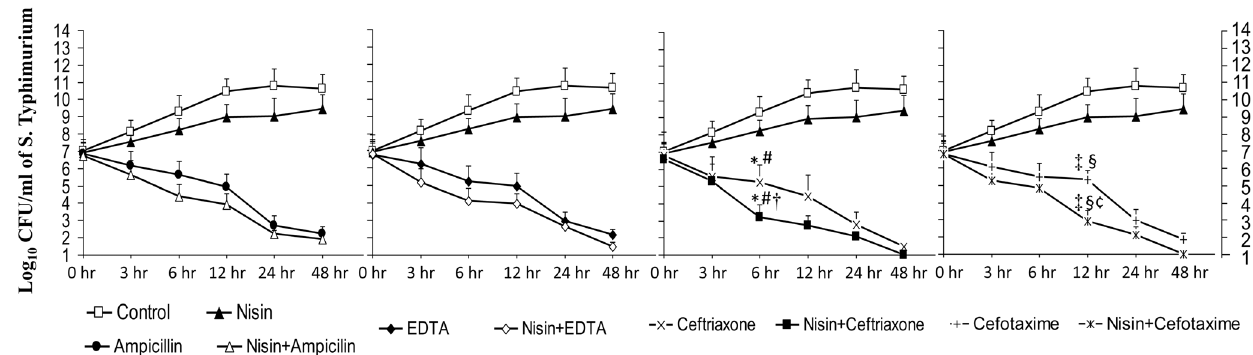
Figure 2. Log 10 CFU/ml of Salmonellaenterica serovar Typhimurium at different time intervals in presence of antibiotic alone (MIC) and in presence of nisin + antibiotic (1 6 MIC + 1 6 MIC). Values are expressed as mean 6 standard deviation of three individual values. *, P , 0.001 versus log 10 CFU of serovar Typhimurium after 6 hour in the absence of any antibacterial agent (control); # , P , 0.01 versus log 10 CFU of serovar Typhimurium after 6 hour in the presence of nisin (400 m g/ml); { , P , 0.05 versus log 10 CFU of serovar Typhimurium after 6 hour in the presence of ceftriaxone (12 m g/ml); ` , P , 0.001 versus log 10 CFU of serovar Typhimurium after 12 hour in the absence of any antibacterial agent (control); 1 , P , 0.01 versus log 10 CFU of serovar Typhimurium after 12 hour in the presence of nisin (400 m g/ml); ¢, P , 0.05 versus log 10 CFU of